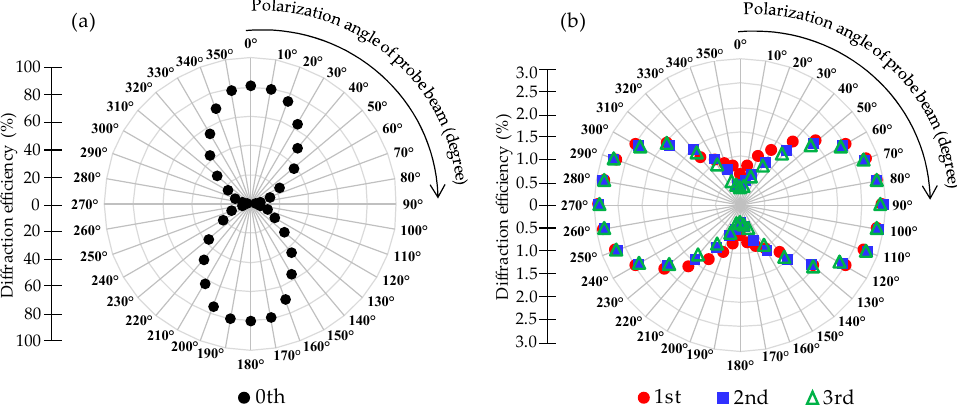
Figure 9. Polarization analysis of the diffraction of ( a ) the zeroth order and ( b ) the first to third order.